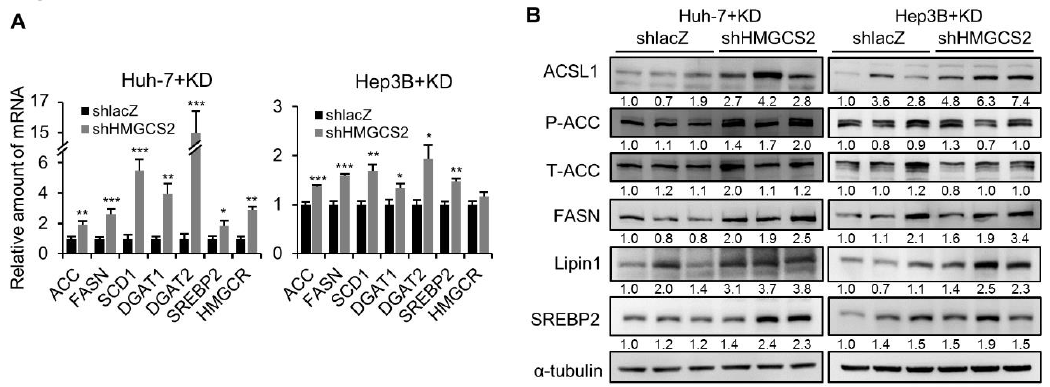
Figure 5. HMGCS2-downregulated tumors had increased expression of lipogenesis-related markers under KD feeding. ( A ) qPCR analyses of ACC, FASN, SCD1, DGAT1, DGAT2, SREBP2, and HMGCR gene expression and ( B ) western blot analyses of ACSL1, T / P-ACC, FASN, Lipin1, and SREBP2 expression of KD fed shlacZ and shHMGCS2 tumors. The quantification of the western blot images was presented by using the ImageJ system, and the whole blot images can be found in Figure S12. The Mann–Whitney U test was used to compare two independent groups. * p < 0.05; ** p < 0.01; *** p < 0.001 vs. the black bar.